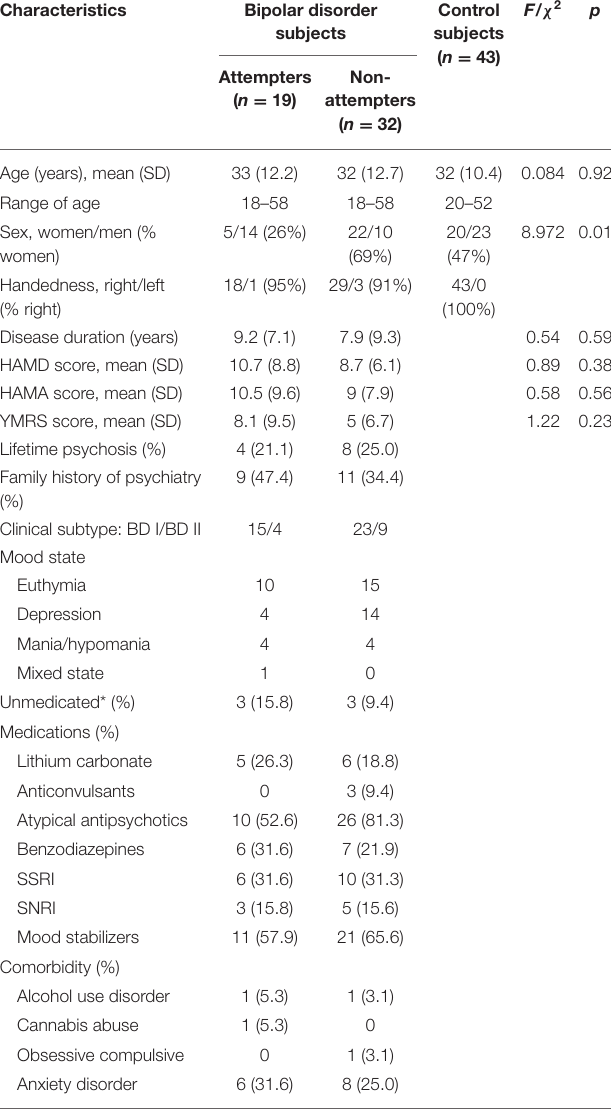
TABLE 1 | Demographic and clinical characteristics of